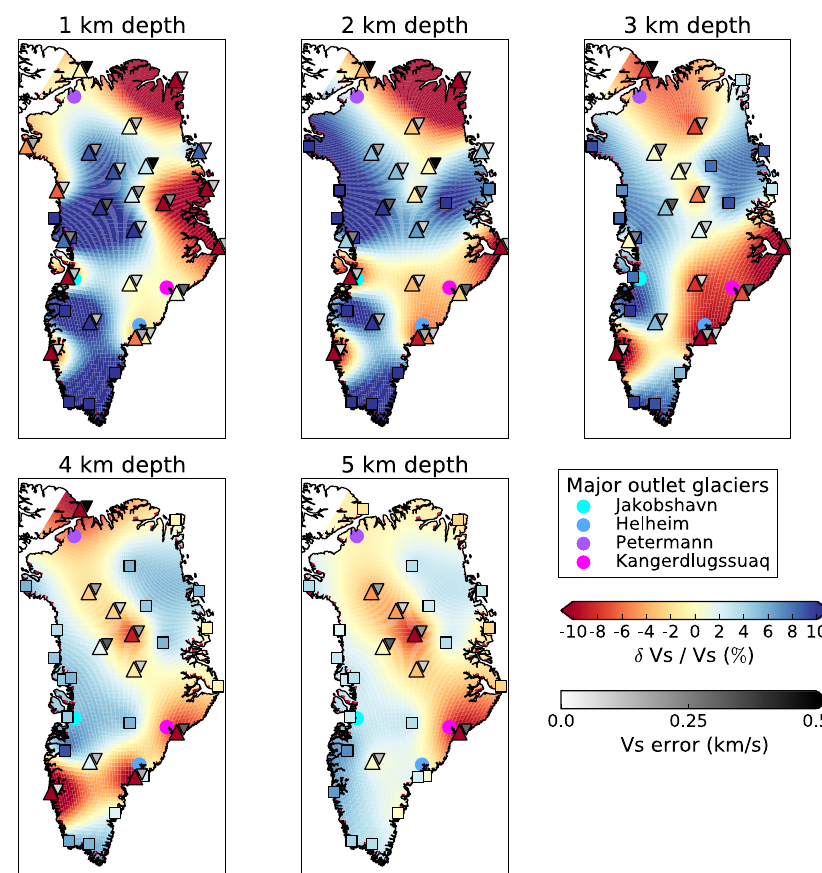
Fig. 7 Percentage perturbation shear wave speed at each station with respect to the average at each depth slice. The colours of the upright triangles are the δ V s percentage perturbation values calculated at that station. The squares are stations that match LITHO1.0. The smaller inverted triangles are the range of V s taken from the 20% ensemble models. For on-ice stations, the ice-sheet layer has been removed.